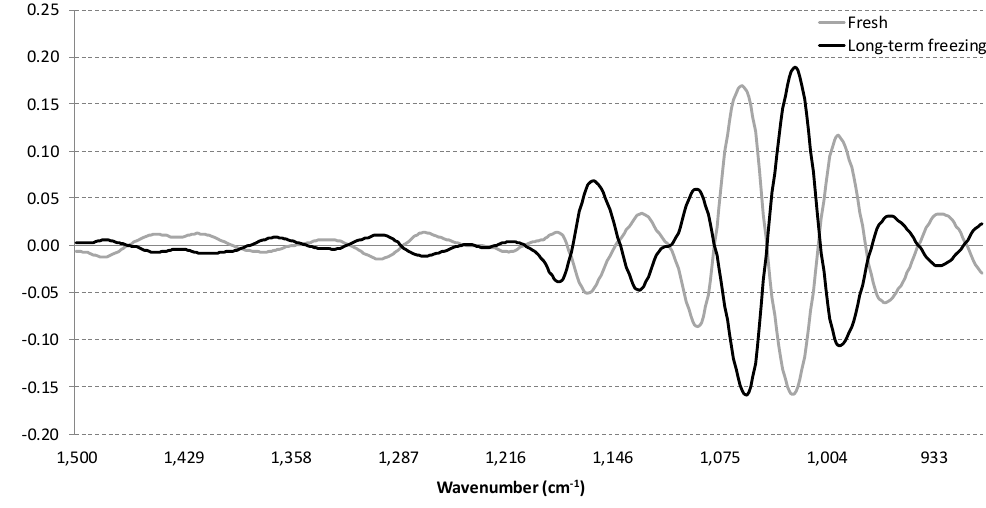
Figure 6. Loadings for the second PC for the MIR fingerprint region (1500–900 cm − 1 ) of carbonated